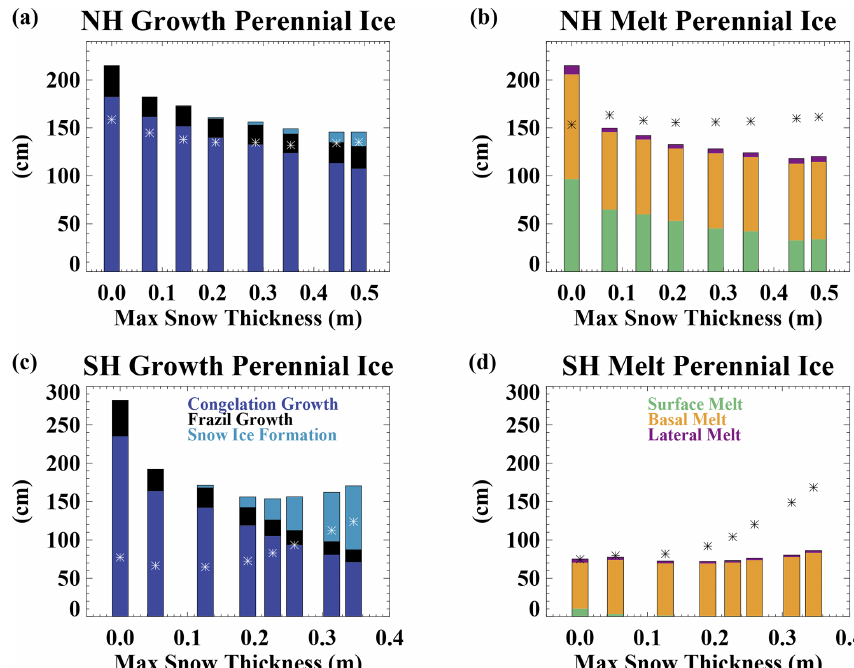
Figure 9. The perennial ice zone average (a) Northern Hemisphere ice growth, (b) Northern Hemisphere ice melt, (c) Southern Hemisphere ice growth, and (d) Southern Hemisphere ice melt as a function of the maximum perennial ice zone snow depth across the simulations. The asterisks show the net ice growth and melt for the seasonal sea ice domain for comparison (shown in more detail in Fig. 10). Note that the imbalance between the net ice growth and melt in an individual experiment results from ice motion that transports ice between the perennial and seasonal sea ice zones.